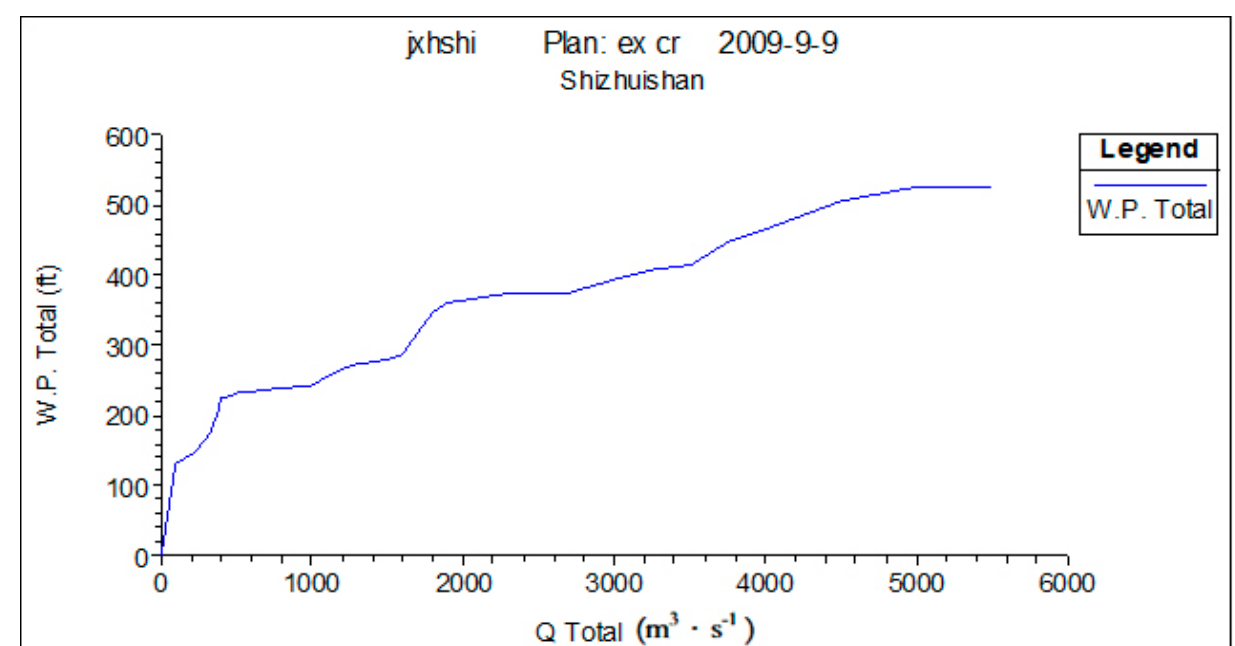
Figure 4. Flow velocity change at Shizuishan cross under different flows. Source: China Water Resources Yearbook, 2018.